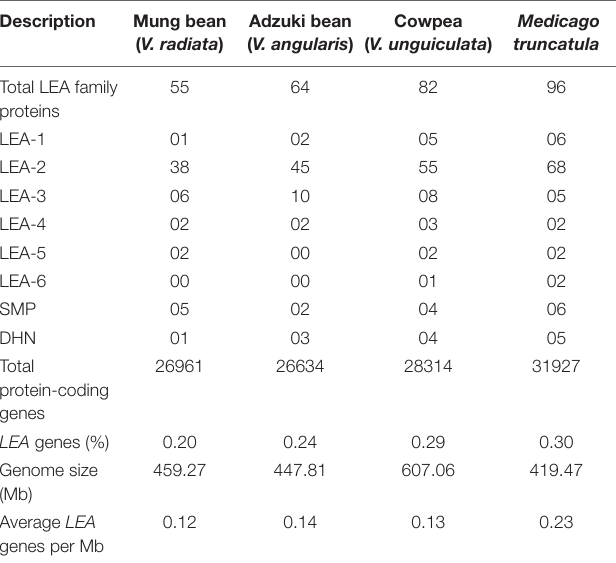
TABLE 1 | The proportions of late embryogenesis abundant ( LEA ) genes in three Vigna and Medicago truncatula genomes*.